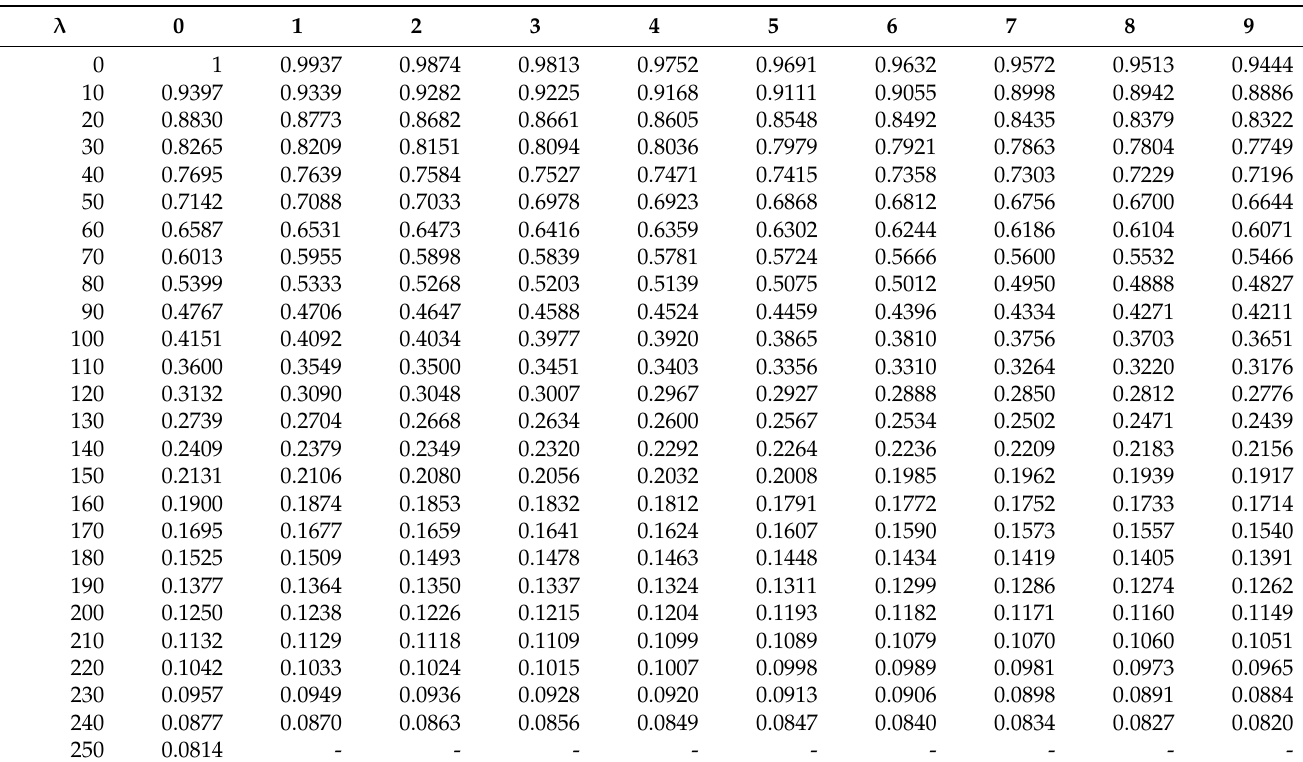
Table 3. Stability factor of fastener-type steel pipe support.